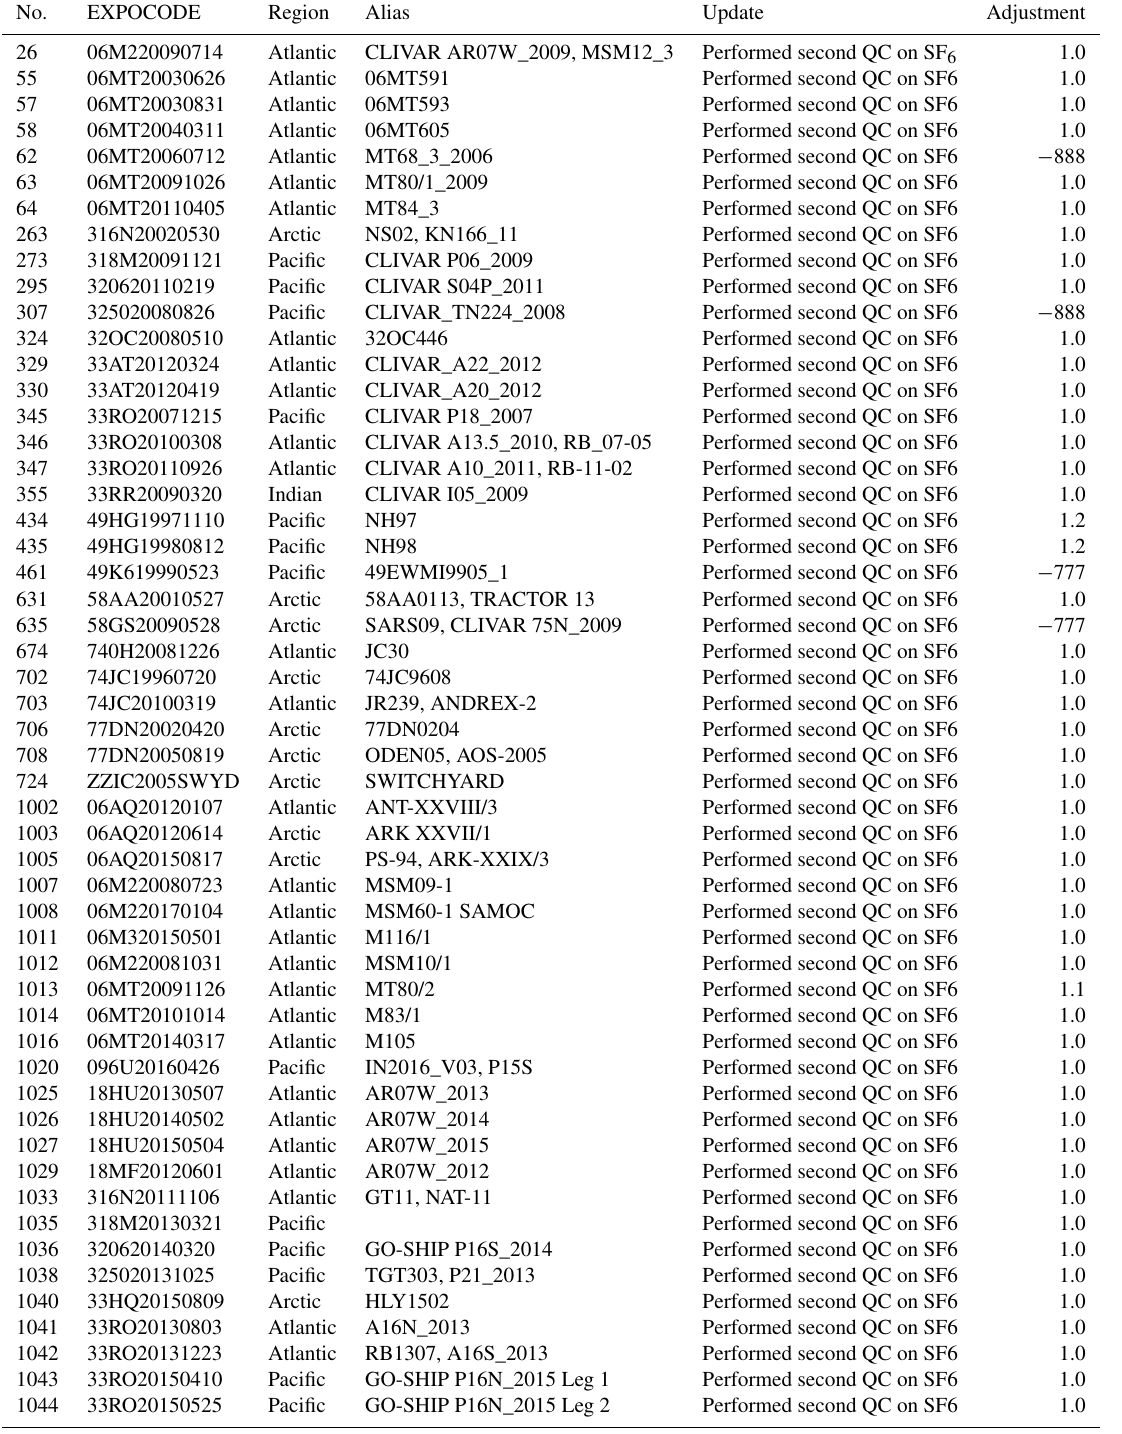
Table A2. List of cruises included in GLODAPv2.2021 which have been updated as part of GLODAPv2.2022. Complete informa- tion on each cruise, such as variables included, and chief scientist and principal investigator names is provided in the cruise summary table at https://www.ncei.noaa.gov/access/ocean-carbon-acidification-data-system/oceans/GLODAPv2_2022/cruise_table_v2022.html (last access: 15 August